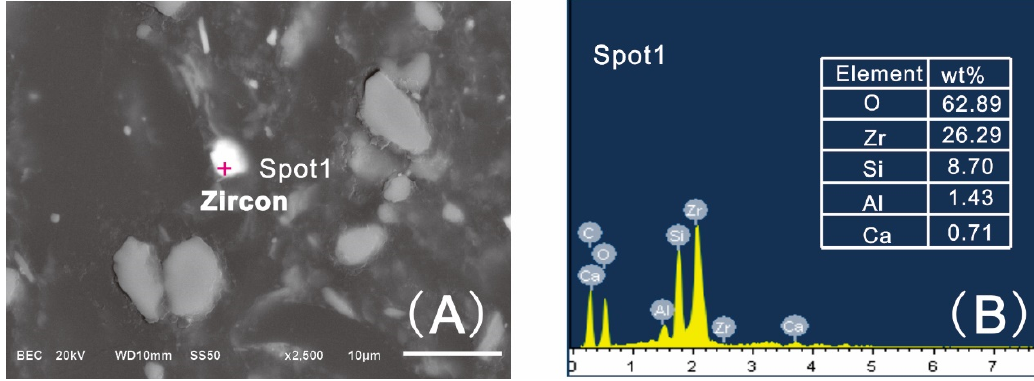
Figure 10. Nb/Ta, Zr/Hf and U/Th ratio variations in coal seam profile from the Dongzhou mine.